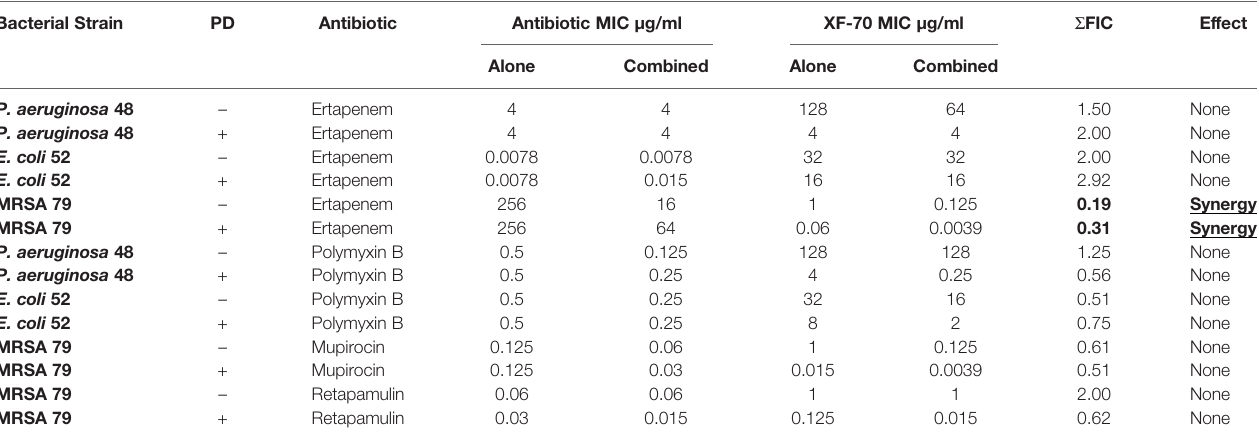
TABLE 2B | Synergistic effects of XF-70 with